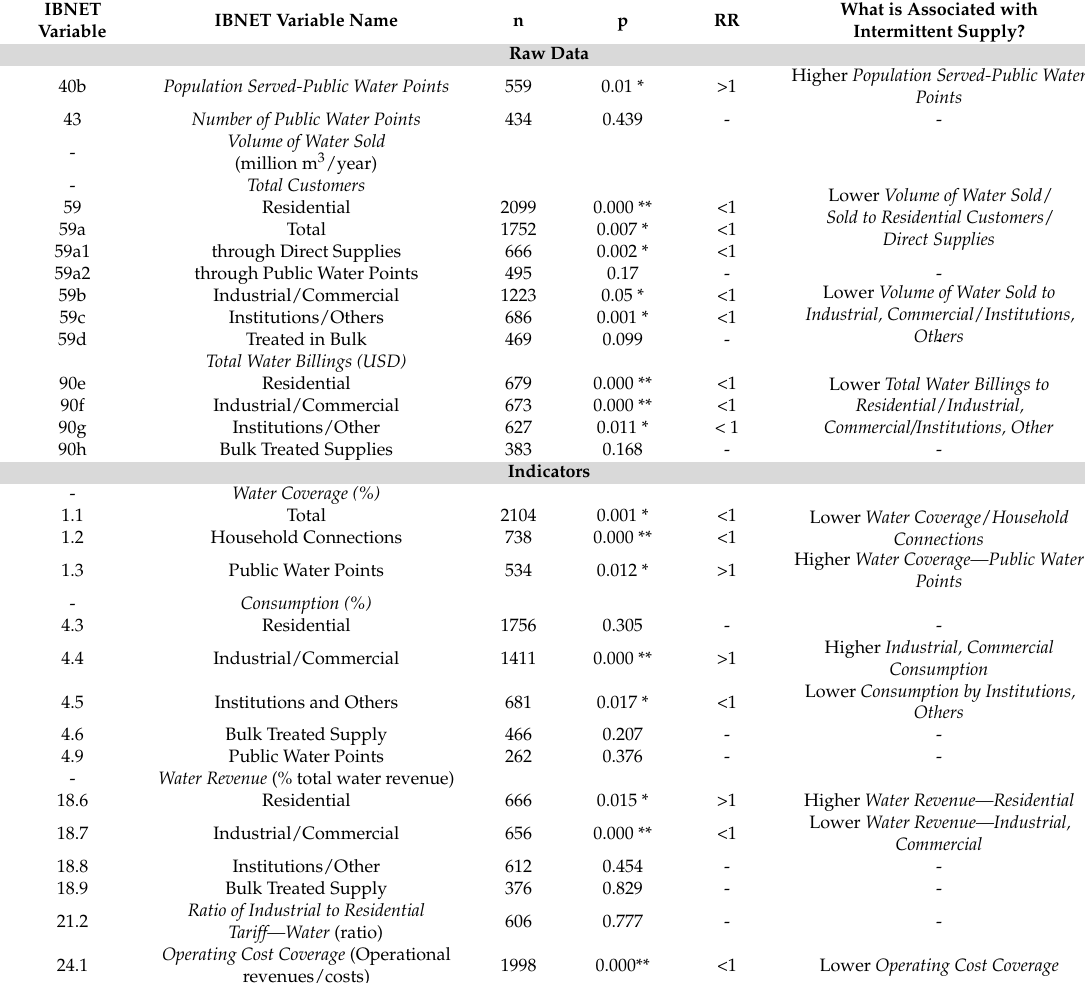
Table 3. A selection of variables related to coverage, water consumer type, and public water points and their relationship to intermittent (<24 h) vs. continuous (24 h) supply. Includes variable number and names as used in the IBNET database (ib-net.org), number of observations (n), the p value (p), the relative risk ratio (RR), and an interpretation of the